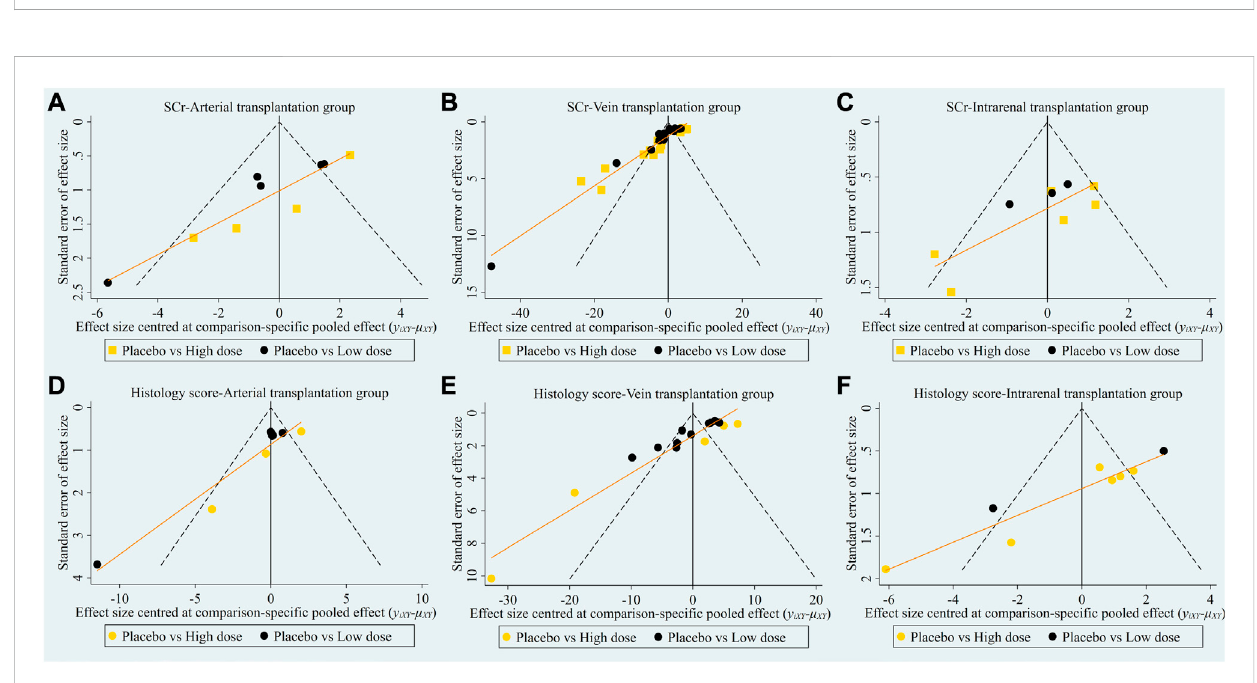
FIGURE 8 Comparison-correctionfunnelplotofdifferenttransplantationdoses. (A) SCr-Arterial transplantation group. (B) SCr-Veintransplantationgroup. (C) SCr-Intrarenal transplantation group. (D) Histology score-Arterial transplantation group. (E) Histology score-Vein transplantation group. (F) Histology score-Intrarenal transplantation